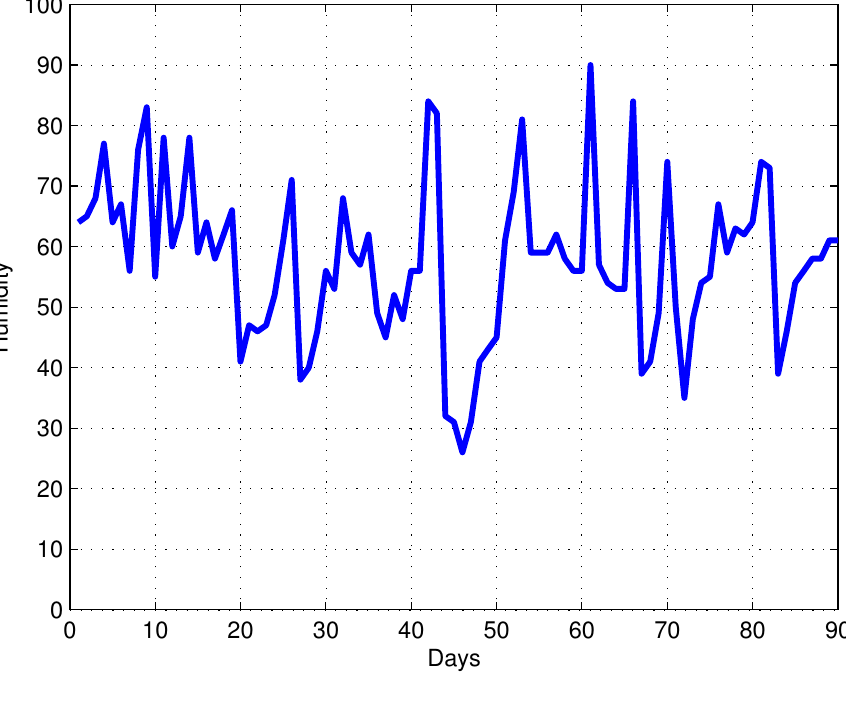
Figure 8. Three-month humidity measurement campaign data.